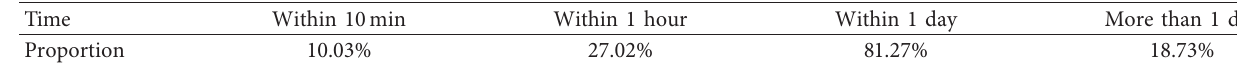
Figure 5: Number of reported rumors related to COVID-19. Table 4: Reported time distribution of rumors about COVID-19.